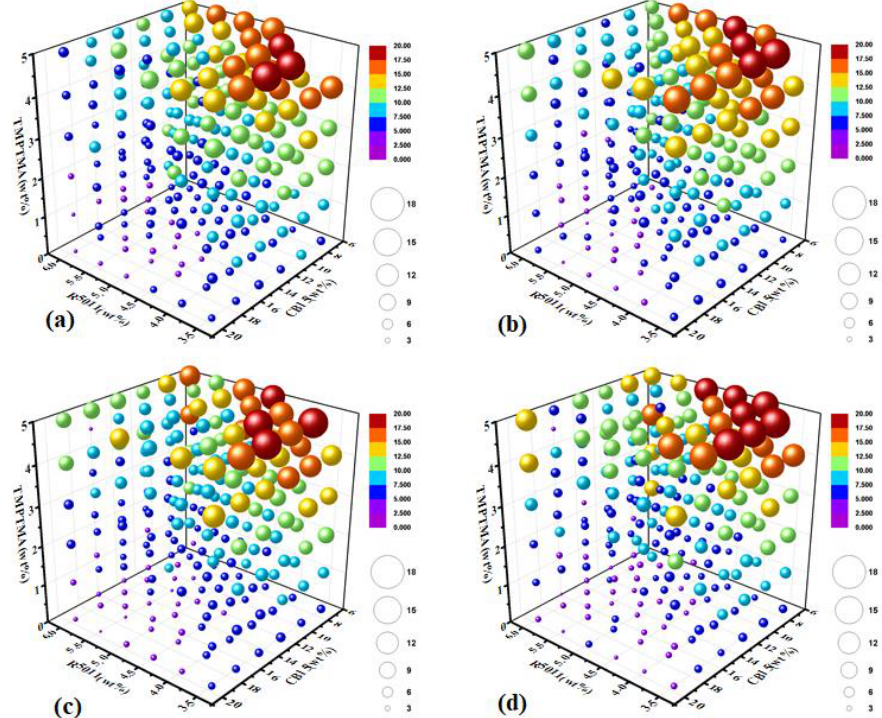
Figure 5. ( a – d ) Four-dimensional graph of the blue-phase (including spherical phase) temperature range with different C6M doping amount (0 wt%, 5 wt%, 7.5 wt% and 10 wt%) taking the doping amount of R5011, CB15 and TMPTMA as the coordinate axis.